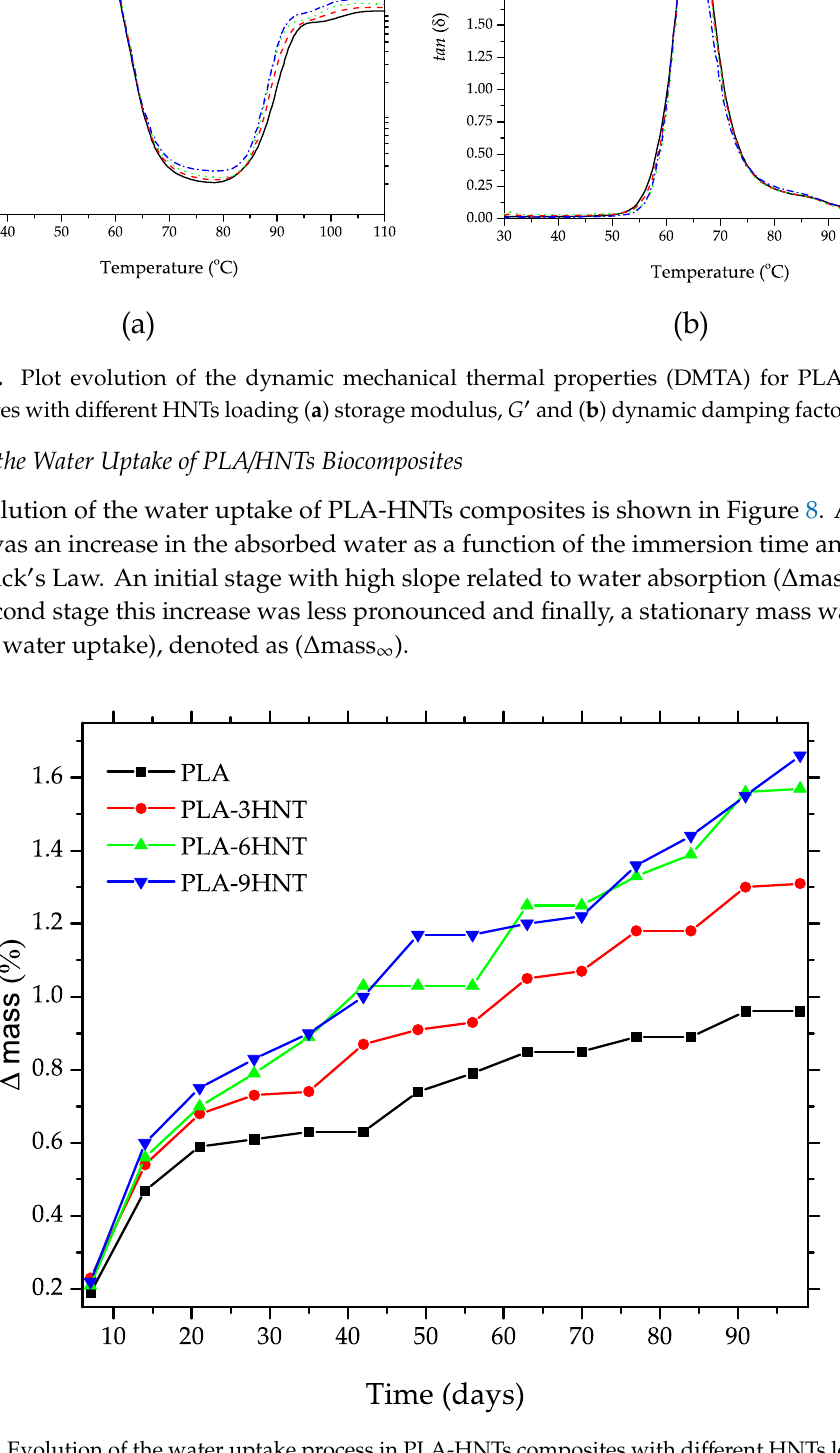
Figure 8. Evolution of the water uptake process in PLA-HNTs composites with different HNTs